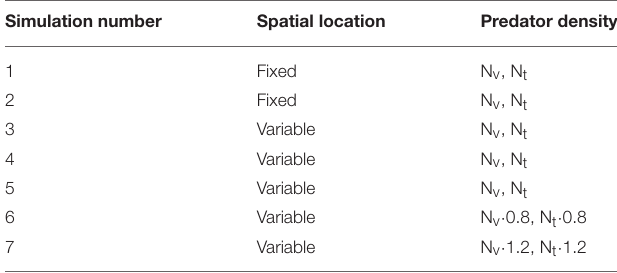
TABLE 1 | Description of the different sensitivity simulations.